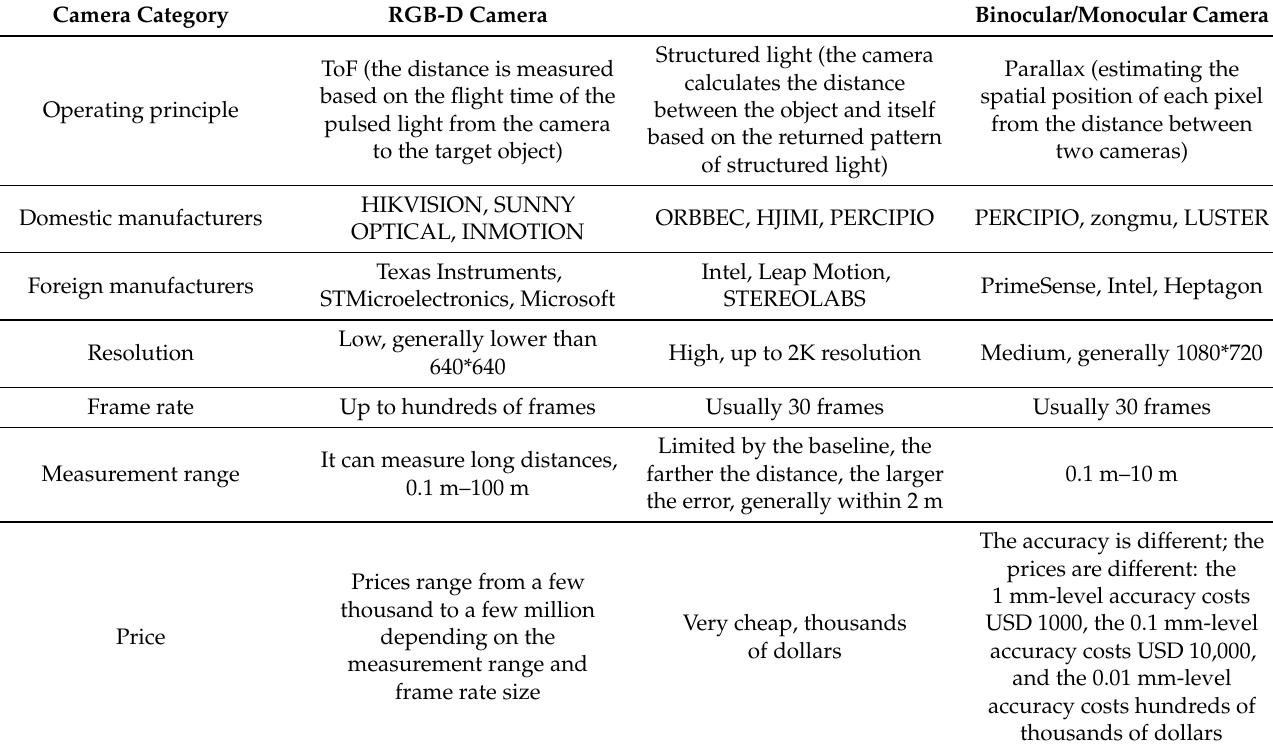
Table 1. Working principle of monocular, binocular, and RGB-D cameras, information of domestic and foreign manufacturers, and related hardware.